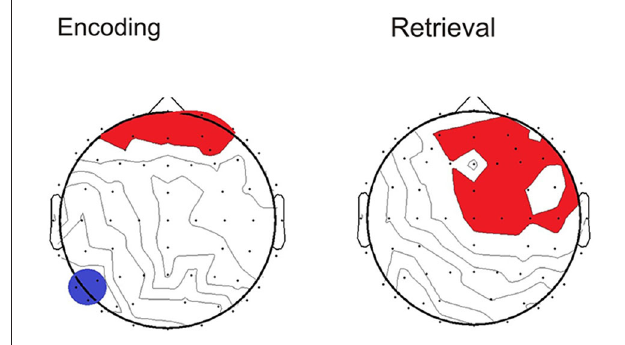
FIGURE 5 | Topographical maps display the Pearson’s r correlation between task performance and SSVEP amplitude for the older group . Time points correspond to the topographical maps shown in Figure 4 . Red highlighting indicates a positive relationship and blue indicates negative ( p < 0.05).